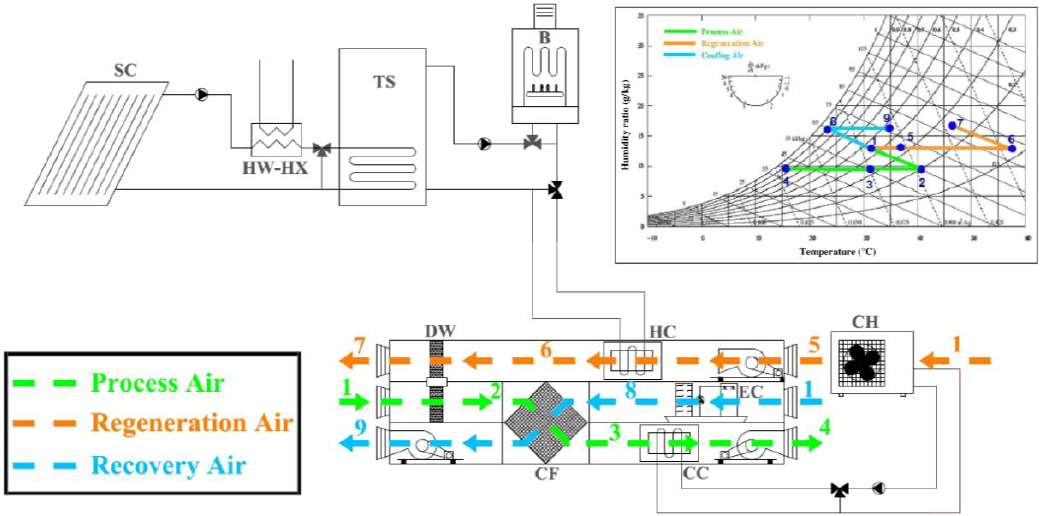
Figure 3. Scheme of the desiccant-based AHU with heat recovery from chiller condenser and psychrometric diagram (cooling operation, Scenario B). psychrometric diagram (cooling operation, Scenario